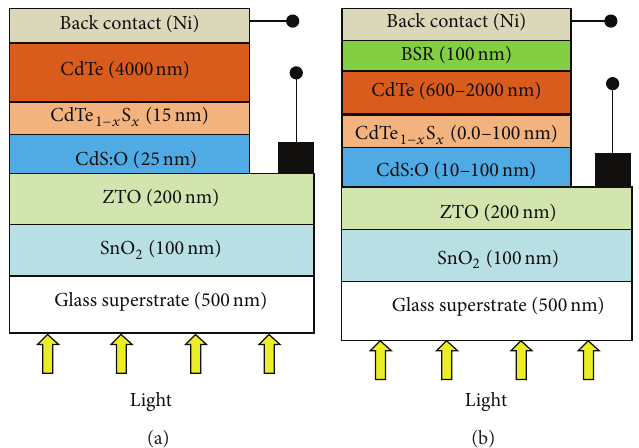
Figure 1: Solar cells structures: (a) reference cell; (b) our proposed cell for higher